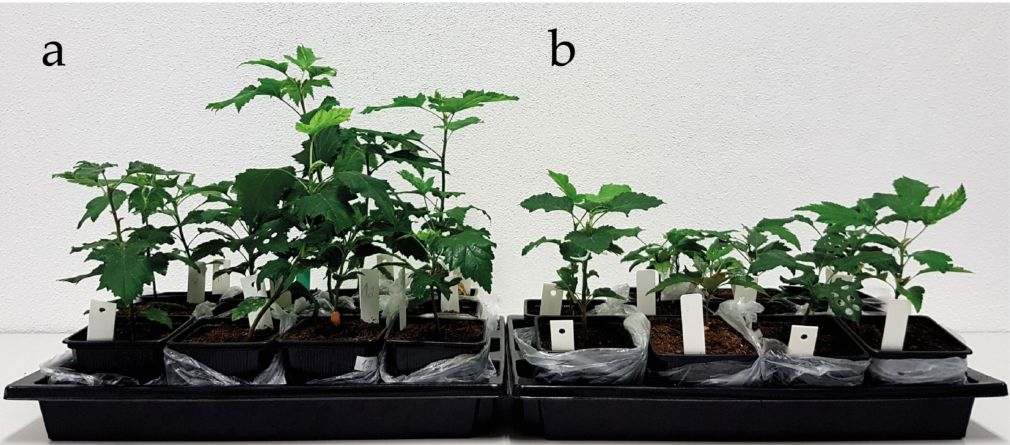
Figure 3. The di ff erences in growth and biomass formation of S. torminalis seedlings grown for 50 days in di ff erent water regimes for 50 days; ( a ) control plants; ( b ) plants under drought